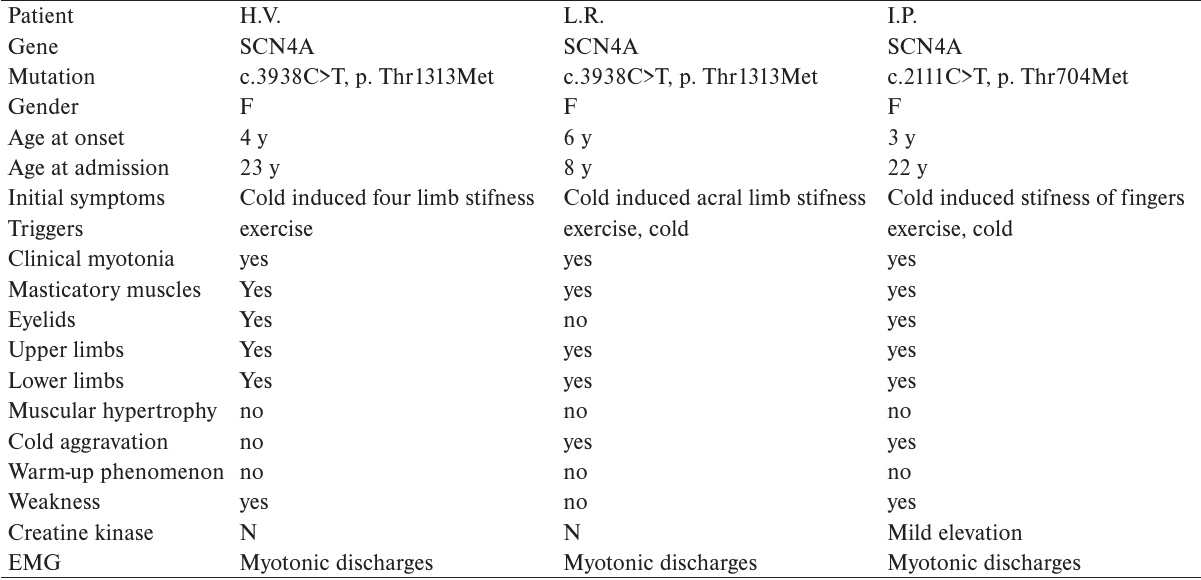
Table 1. Clinical characteristics of probands from families with PMC carrying mutations in SCN4A gene.